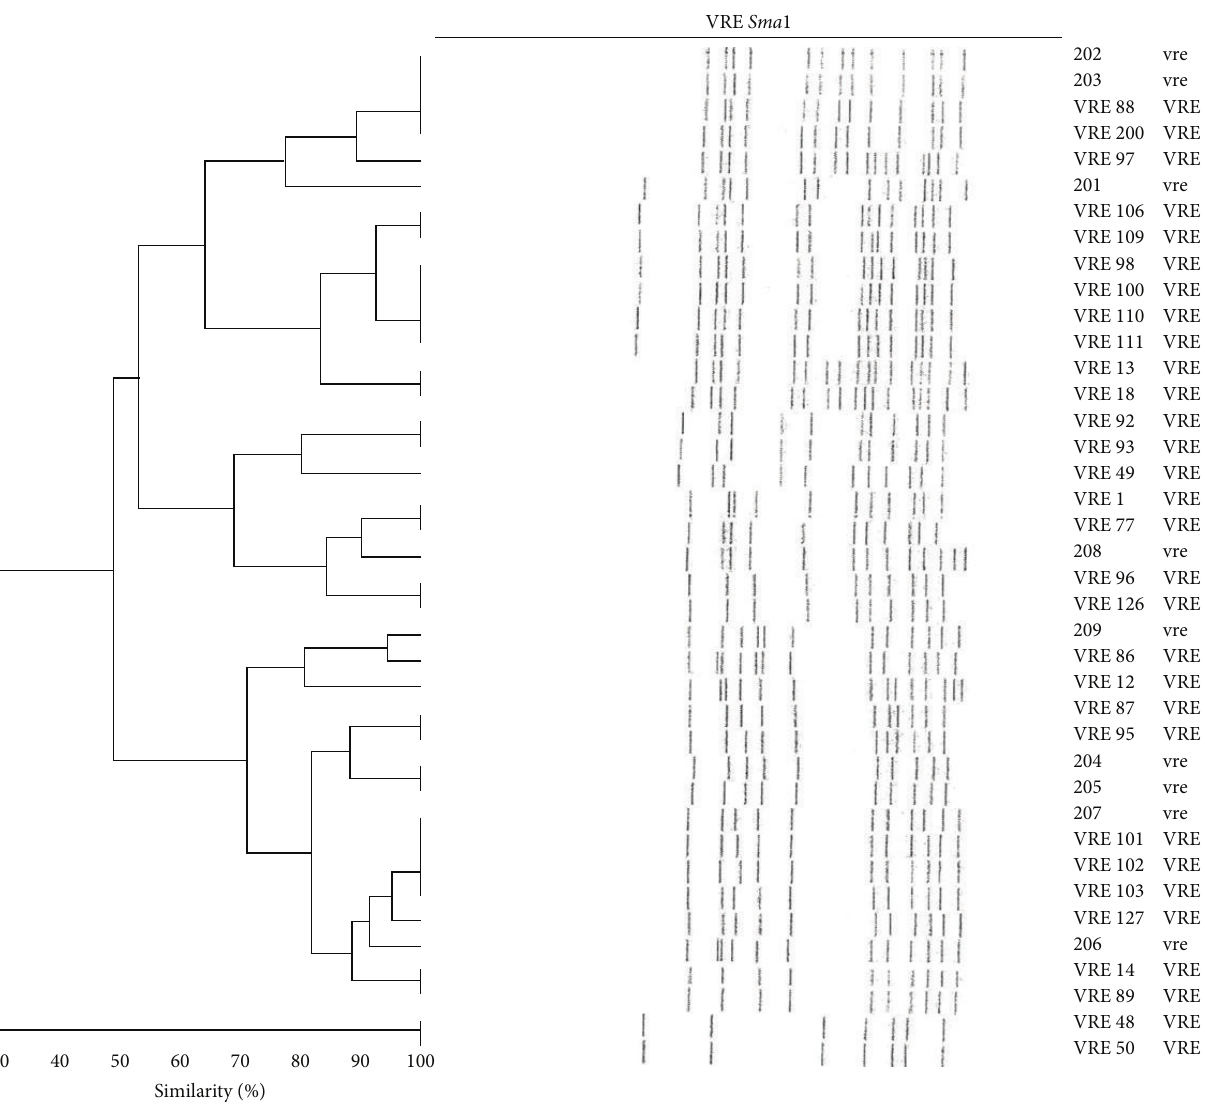
Figure 3: Dendrogram of PFGE vancomycin-resistant E. faecium . Molecular typing of vancomycin-resistant E. faecium from regional hospitals in Trinidad and Tobago. The phylogenetic tree was constructed by use of the Dice coefficient and UPGMA clustering; the band tolerance was set at 1.5%, and the threshold cut-off value was set at